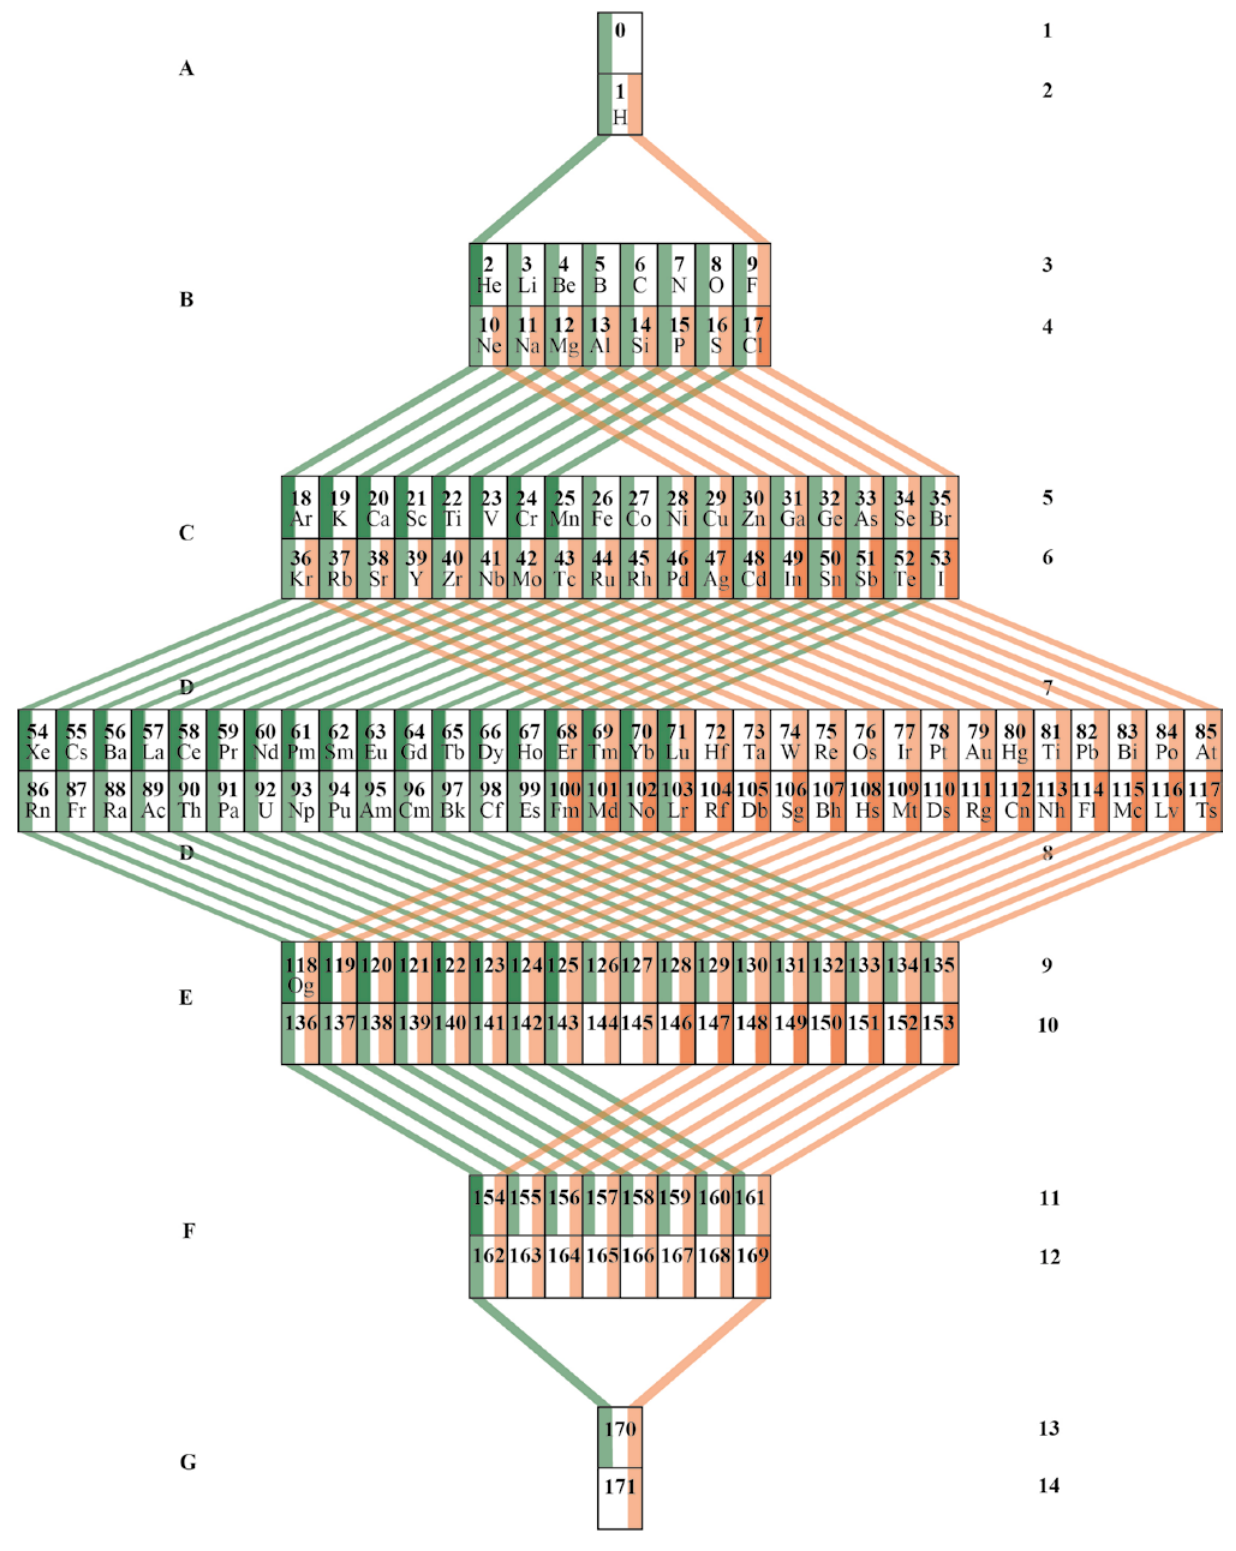
Figure 1. Periodic table bases in triads: in green the triads corresponding to even generations, in orange those corresponding to odd gen- erations. Observe that in each period, a new generation of triads is